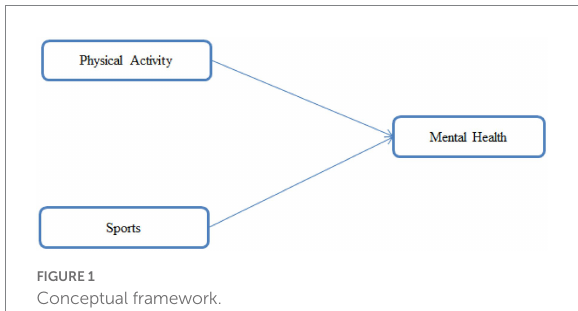
FIGURE 1 Conceptual framework.